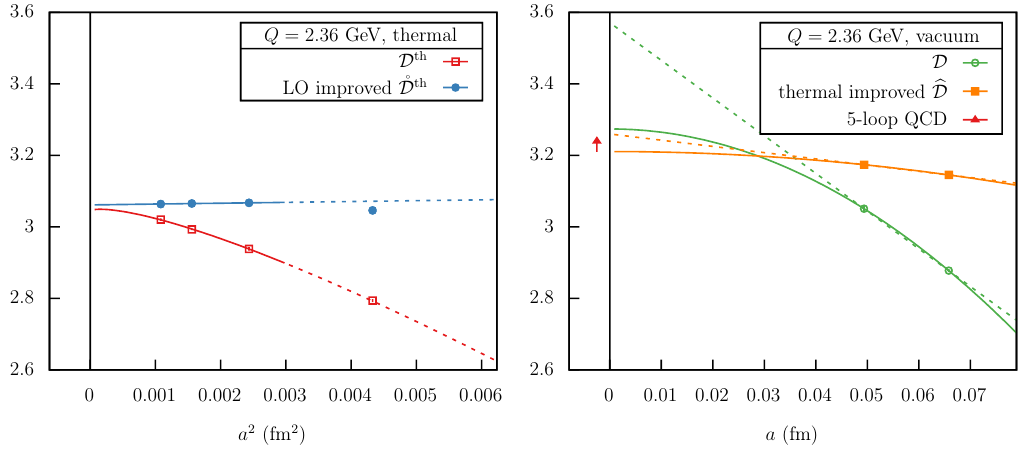
Figure 6 . Continuum limit for the ‘thermal’ Adler function D th ( Q 2 ) (left) and the corresponding vacuum observable D ( Q 2 ) (right) for a large virtuality Q = 2 . 36 GeV. The various data symbols and curves are entirely analogous to those in figure